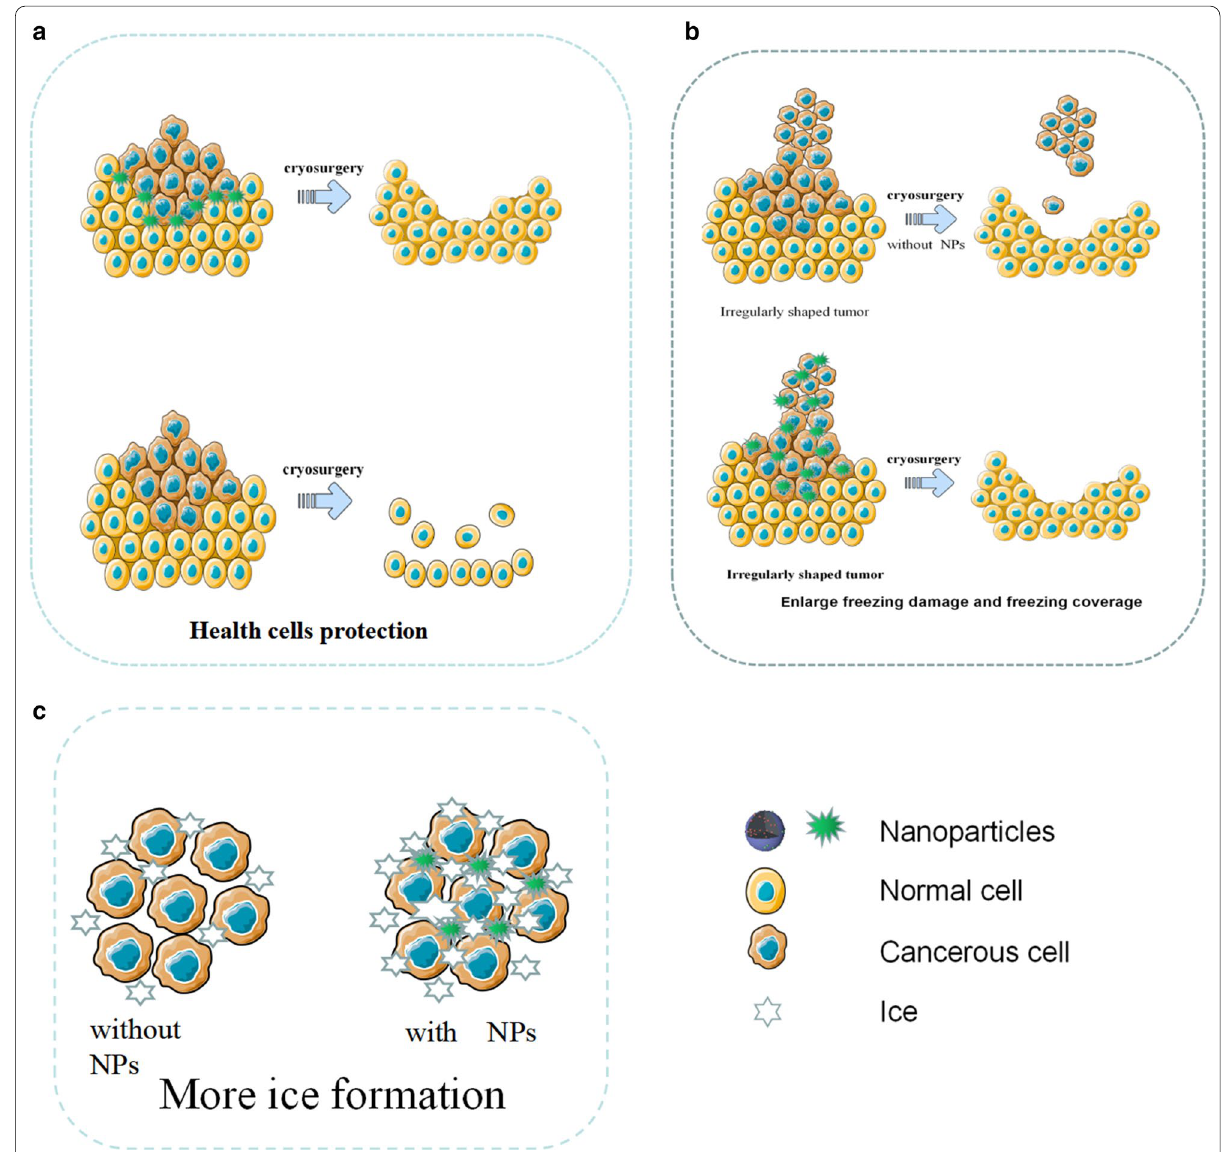
Fig. 5 Diagrammatic illustration of NPs for cryosurgery. a NPs protect health cells during cryosurgery. b NPs enhance the freezing damage and control the freezing coverage. c With the help of NPs, more ice has been